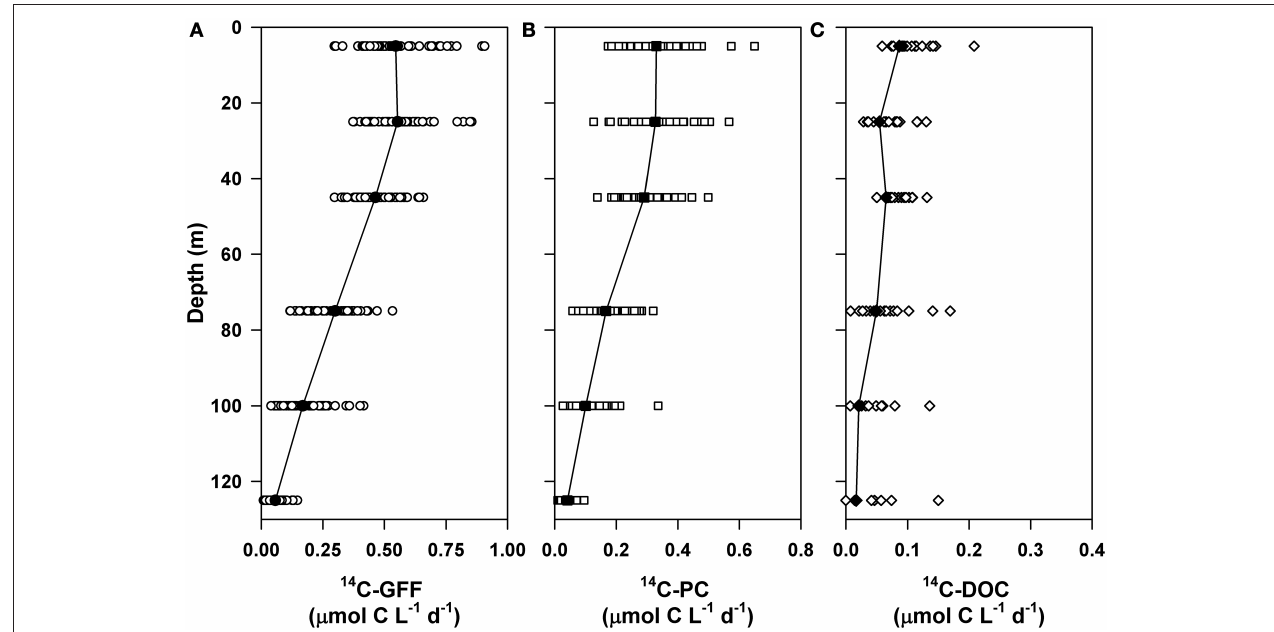
FIGURE 2 | Vertical profiles of rates of 14 C-based primary production filtered onto (A) glass fiber filters ( 14 C-GFF) and (B) 0.2 µ m polycarbonate membrane filters ( 14 C-PC). Also shown are (C) rates of 14 C-DOC